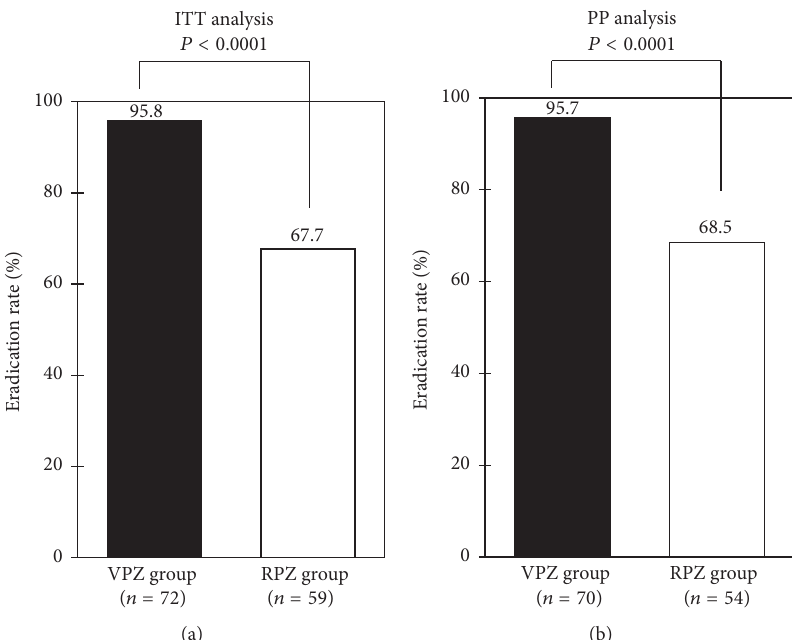
Figure 3: Comparison of eradication rates between vonoprazan- (VPZ-) based regimen and rabeprazole- (RPZ-) based regimen. Intention- to-treat (a) and per-protocol (b) analyses. Statistical analysis was performed by 𝜒 2 test. VPZ group, treatment with vonoprazan, amoxicillin, and clarithromycin; RPZ group, treatment with rabeprazole, amoxicillin, and